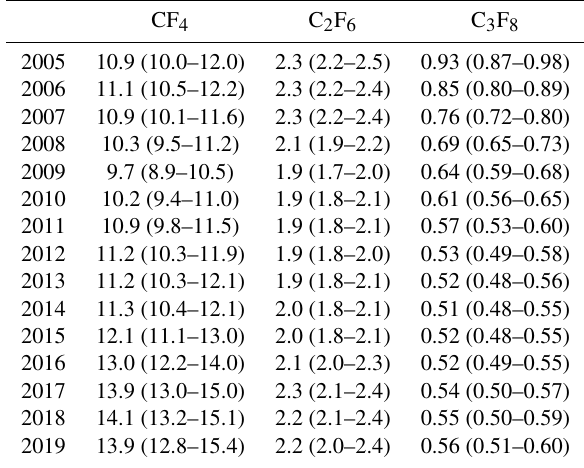
Table 2. Global annual PFC emissions, estimated using the AGAGE 12-box model – an extension of the work by Rigby et al. (2014), Trudinger et al. (2016) and Engel and Rigby (2019) – in gigagrams per year (Ggyr − 1 ). Lower and upper uncertainty bounds corre- spond to the 16th and 84th percentiles of the posterior model distri- bution,